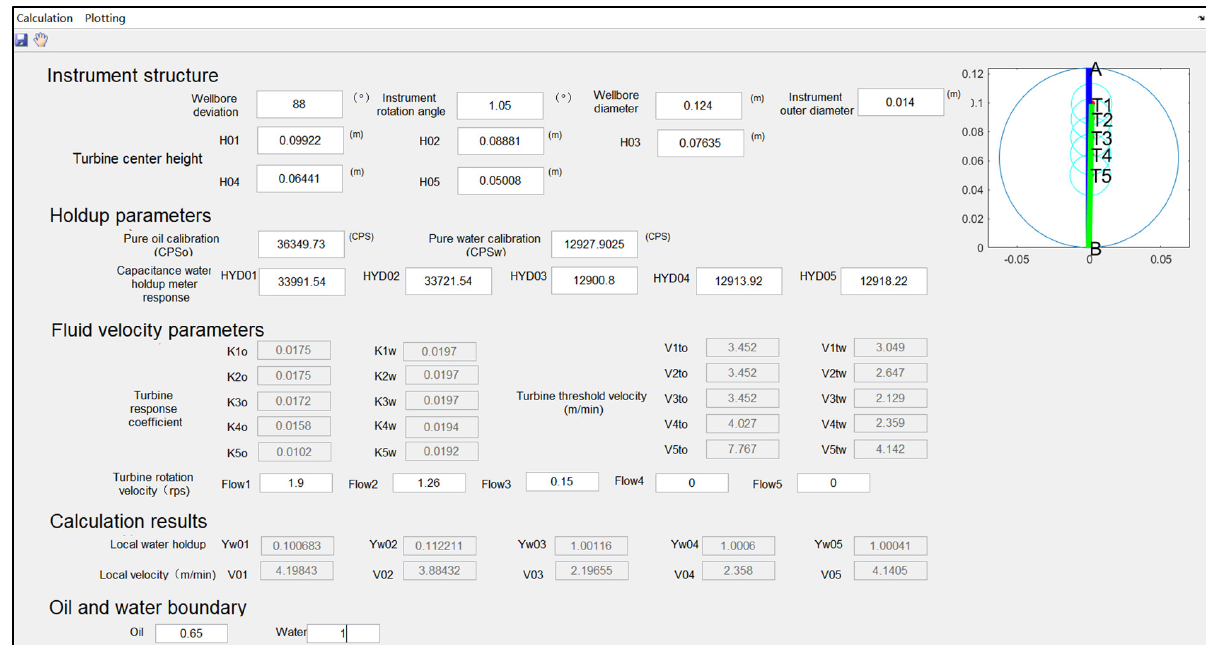
Figure 9. The GUI program and calculation results.